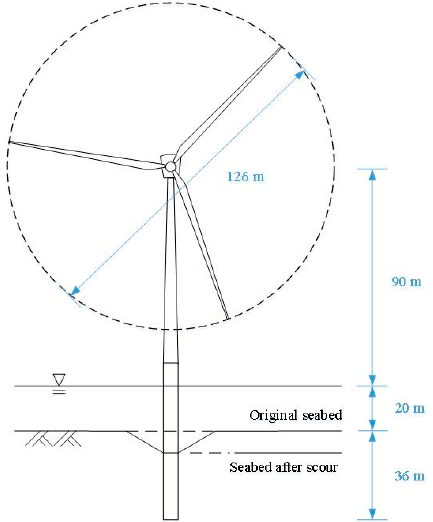
Figure 9. Schematic for the 5 MW offshore wind turbine developed at National Renewable Energy Laboratory (NREL). Table 2. Data regarding the 5 MW offshore wind turbine developed at NREL.